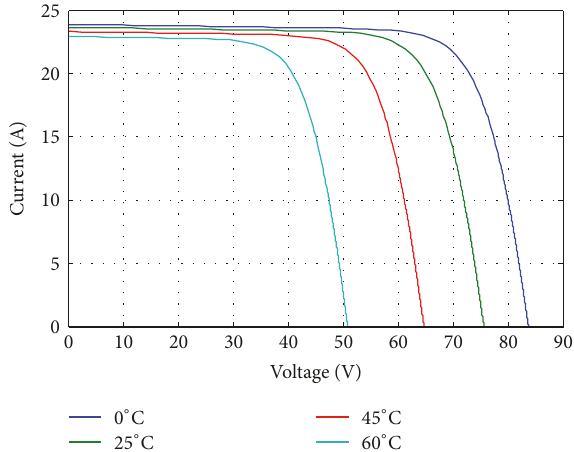
Figure 8: 𝐼 - 𝑉 curves for PV array with different ambient tempera-